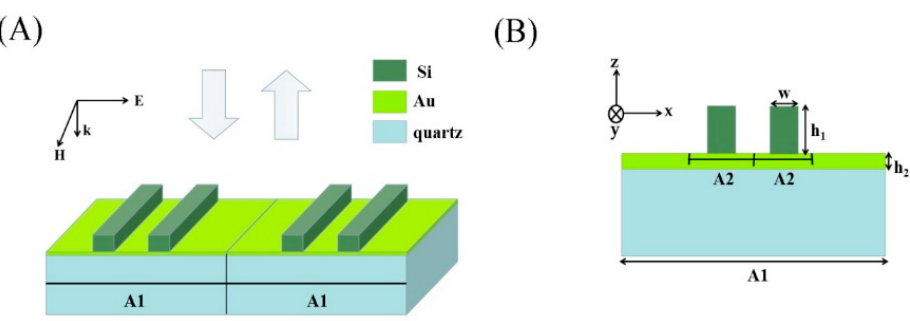
Figure 1. ( A ) Three-dimensional diagram of symmetrical Si grating structure and ( B ) section diagram of element